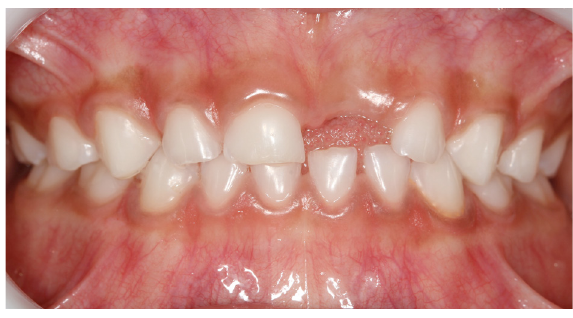
Figure 1. Patient M.A.F.S., male, 5 years old, unilateral premature loss of primary central incisor (61). Intraoral frontal photograph 3 years after premature tooth loss. (Image by